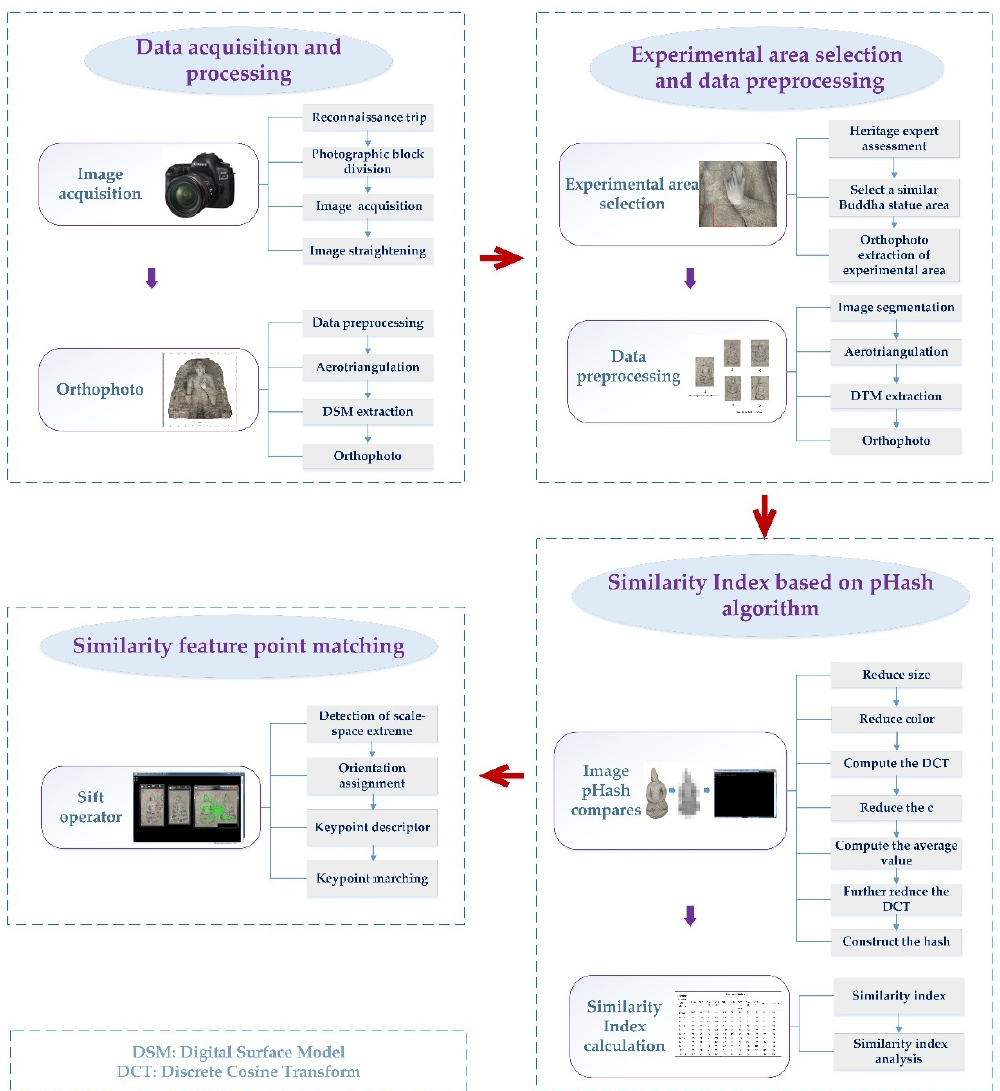
Figure 2. The overall process of the proposed approach.